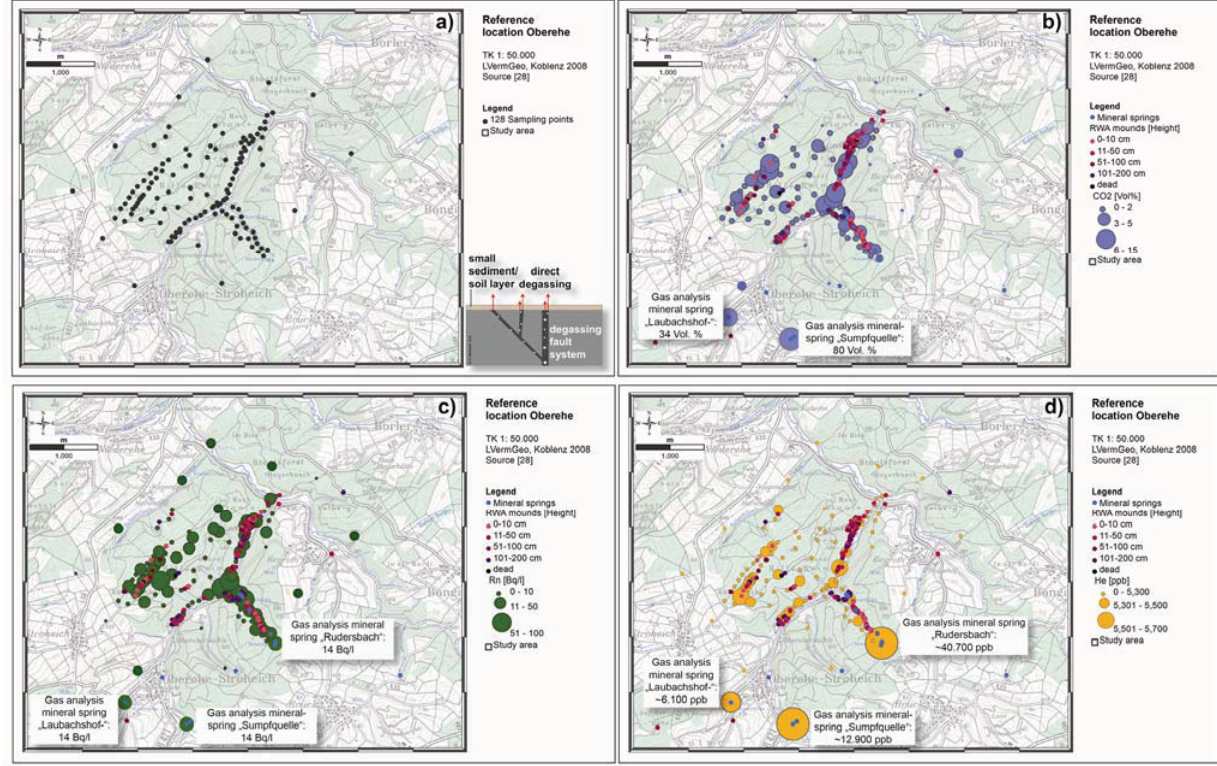
Figure 9. Relationship between soil gas anomalies and alignment of the RWA mounds for the Oberehe site ( a ) showing sampling points (black dots), ( b ) CO (>2 Vol%; blue dots and mineral springs (small blue dots)), ( c ) Radon anomalies (up to 74 Bq/L; green dots) and ( d ) Helium anomalies (He > 5,220 ppb; orange dots). In addition, the concentrations of the three gases in mineral springs are